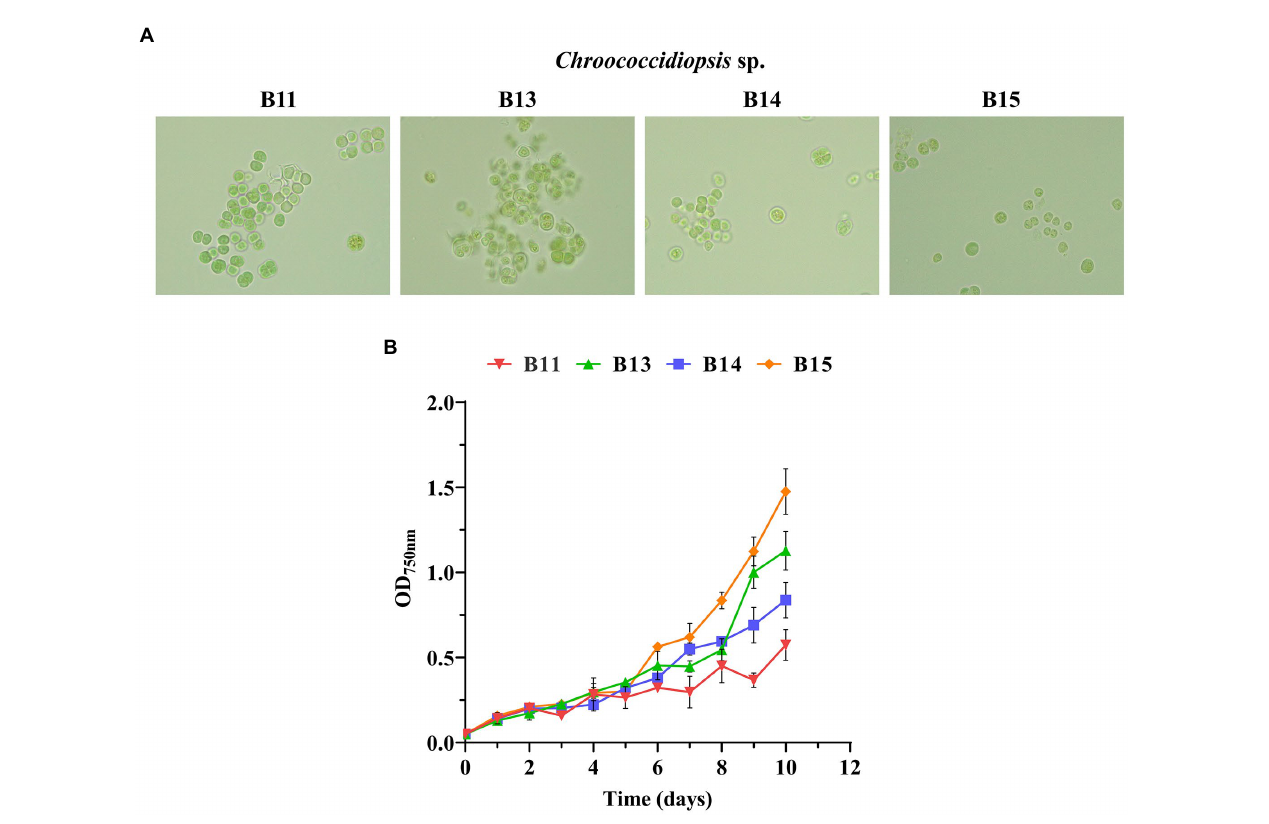
FIGURE 2 Growth curves of Chroococcidiopsis sp. Helios isolates. (A) Bright-field photomicrographs of the chosen isolates taken at the same magnification (100X). (B) Growth curves of some of the isolates. The graph shows the average OD 750nm of three biological replicates together with the standard